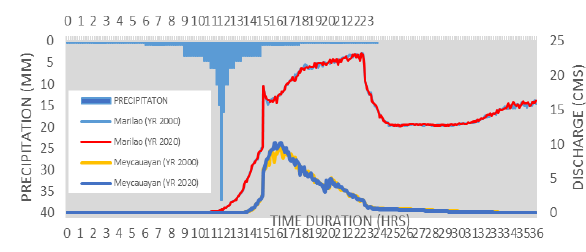
Figure 4.19 Upstream Hydrograph